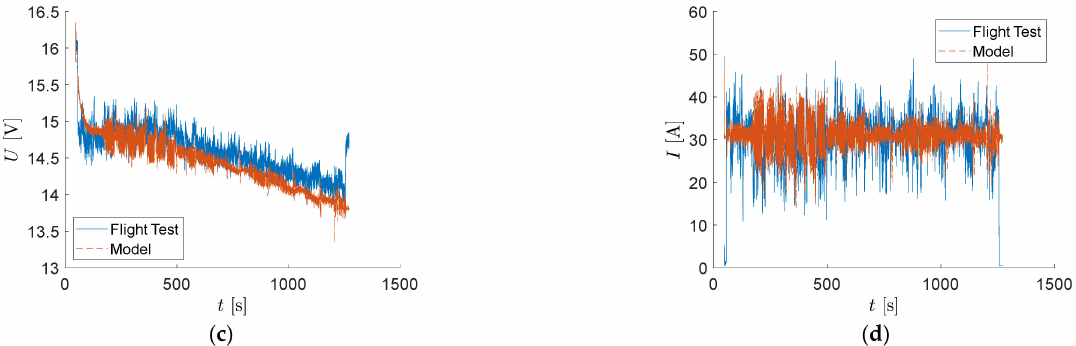
Figure 21. Energetic model: ( a ) total energy consumed by the drone ( b ) battery state of charge, ( c ) voltage, and ( d ) current.